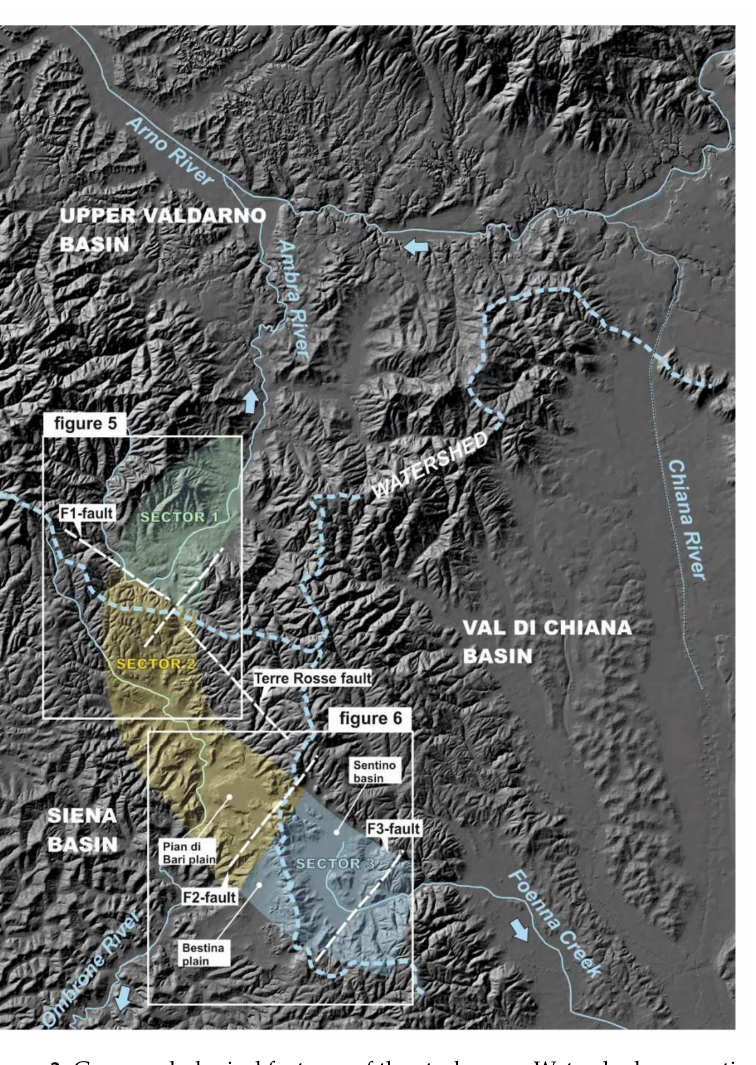
Figure 3. Geomorphological features of the study area. Watersheds separating the major drainage domains are highlighted, along with the key structural features associated with the present study (F1 to 3 faults).